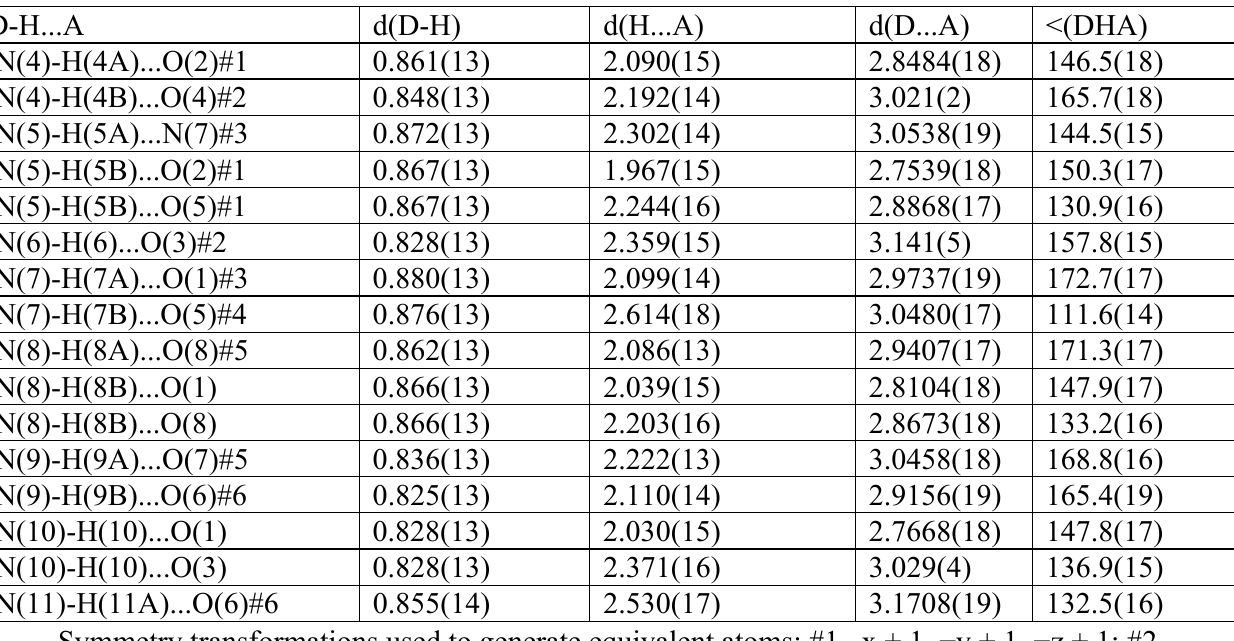
Table 3. Hydrogen bond lengths [Å] and angles [°] for aminoguanidinium